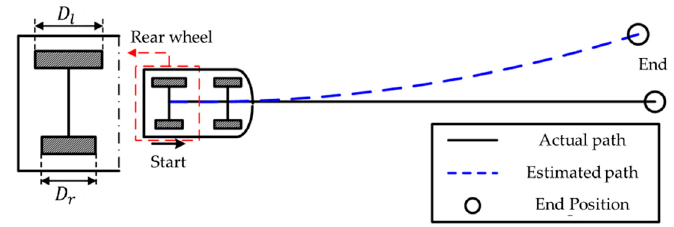
Figure 1. Comparing the actual path and odometry path with the wheel diameter error.